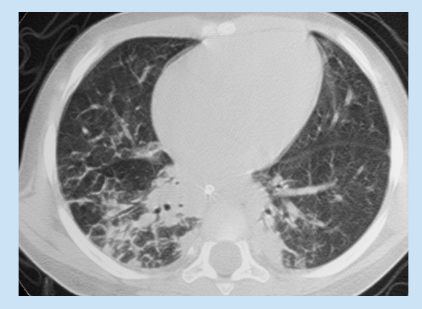
Fig. 1b. (b) Mid/ lower zone scan demonstrating patchy, predominantly peripheral and basal inter- lobular septal thickening outlining the secondary pulmonary lobules. There are associated central and dependent areas of dense air-space disease. The anterior portions of the lung are relatively